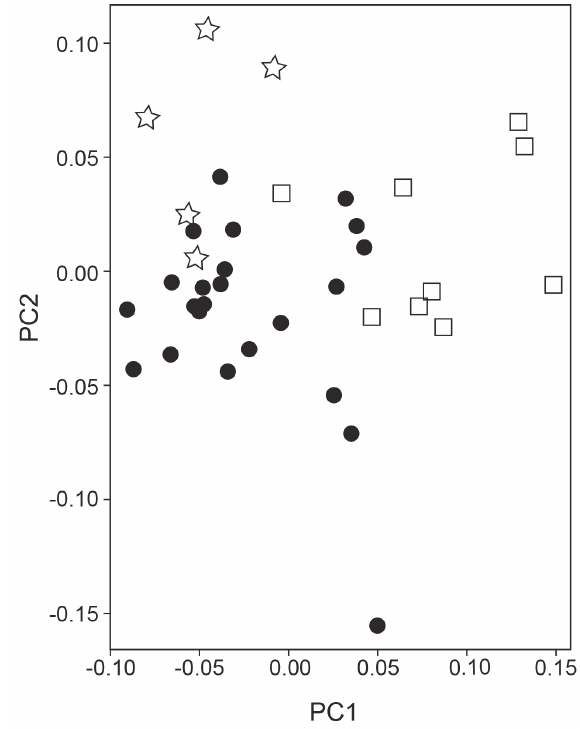
Figure 5. Plots of the first two principal components scores based on 20 body measurements of the three species of Parabembras . Circles, P. curta ; squares, P. robinsoni ; stars, P. multisquamata . spine, body width, and body depth 1, providing separation between P. multisquamata Parabembras . The distributional ranges of the three species are not overlapped, suggest- ing that they speciated